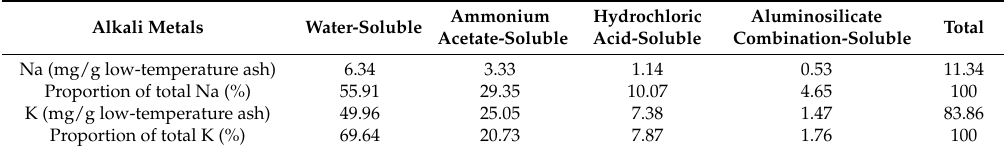
Table 5. Occurrence modes and contents of alkali metals in rice straw.